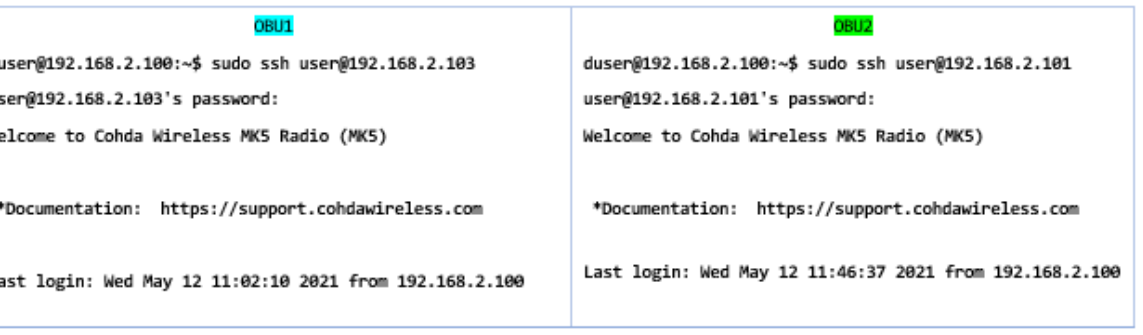
Figure 19. Authentication within the V2X platform.